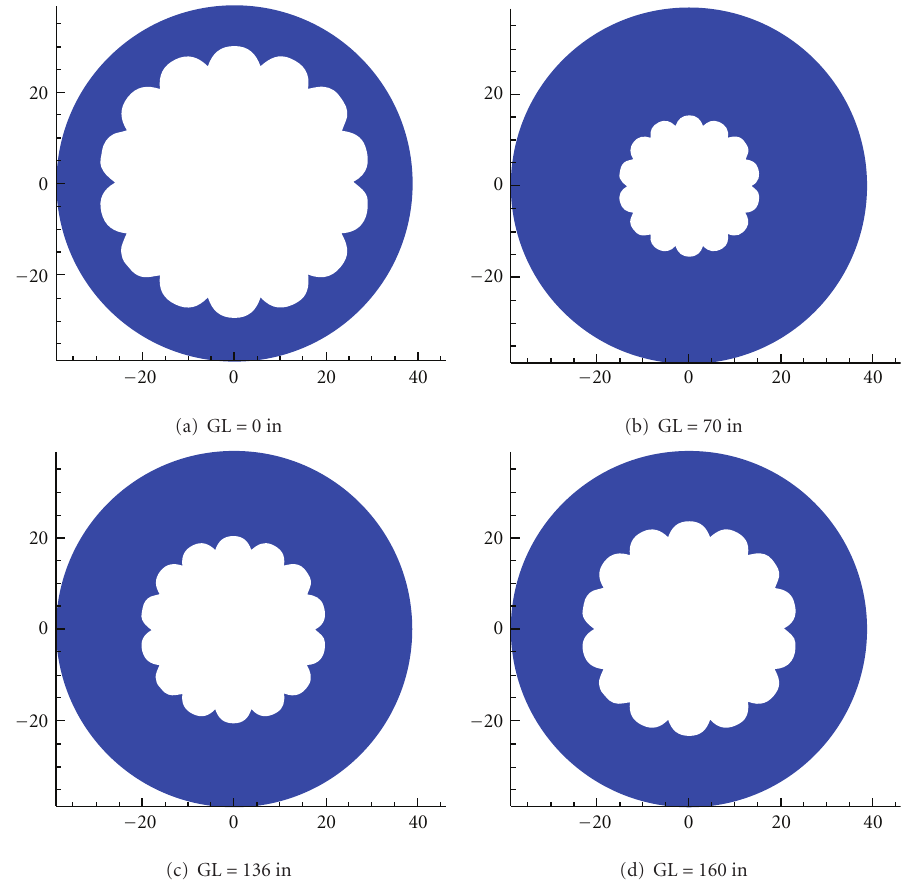
Figure 9: Grain cross section for regressive-progressive-regressive profile.